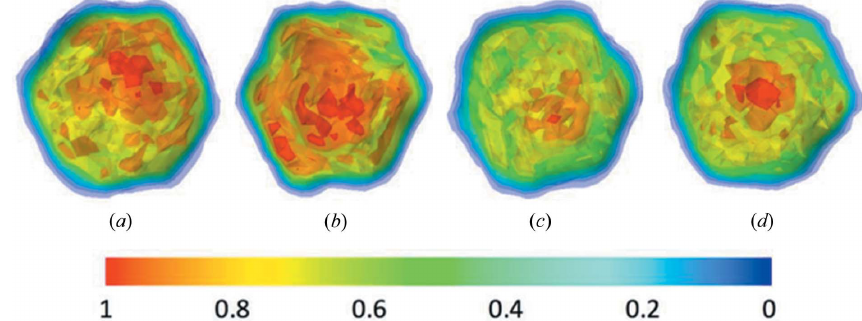
Figure 6 Contour display of the retrieved electron density maps. The maps for the datasets selected using the ( a ) CNN, ( b ) GC, ( c ) DM and ( d ) common